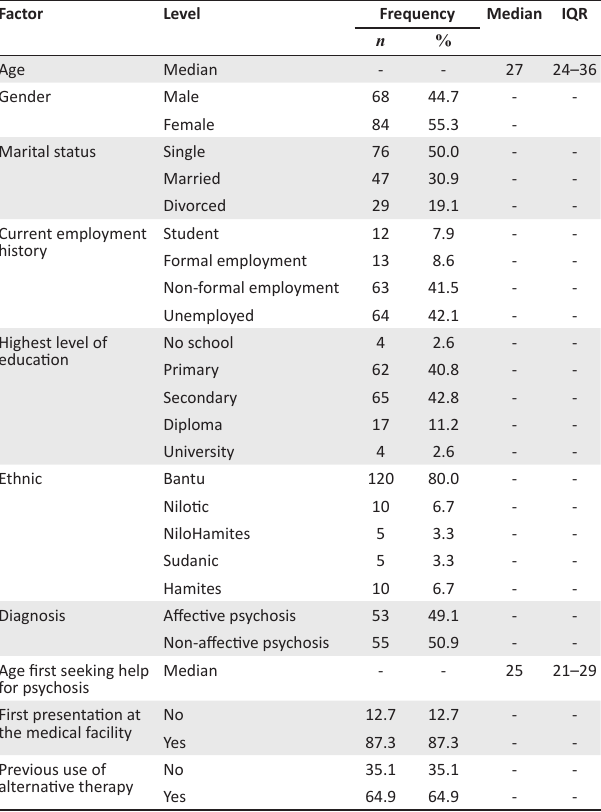
TABLE 3: Baseline characteristics of the participants. Factor